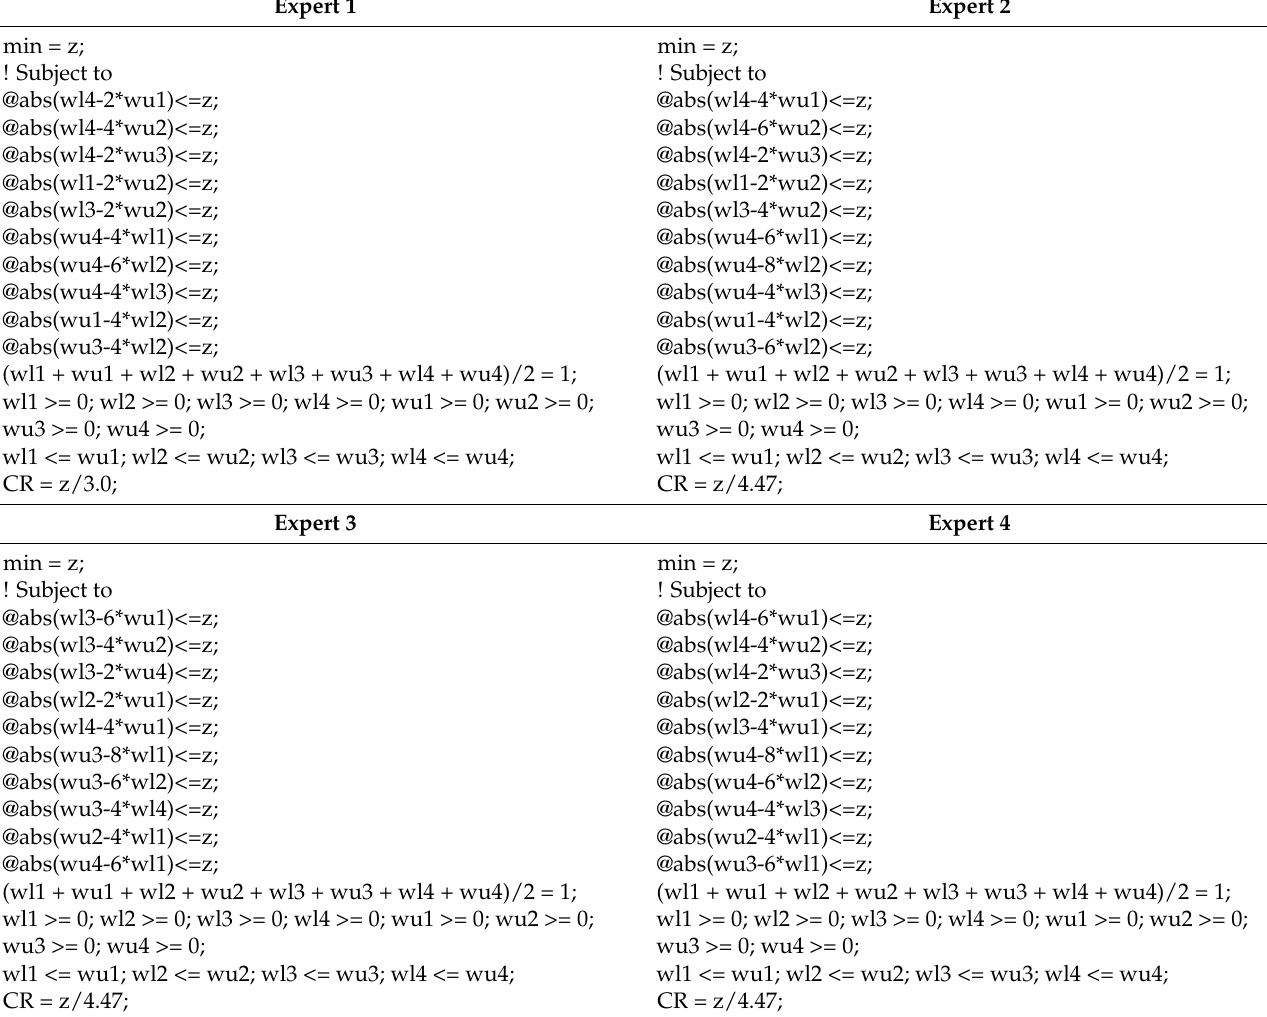
Table A2. Weights of the RPN element calculated by LINGO 19.0. Expert